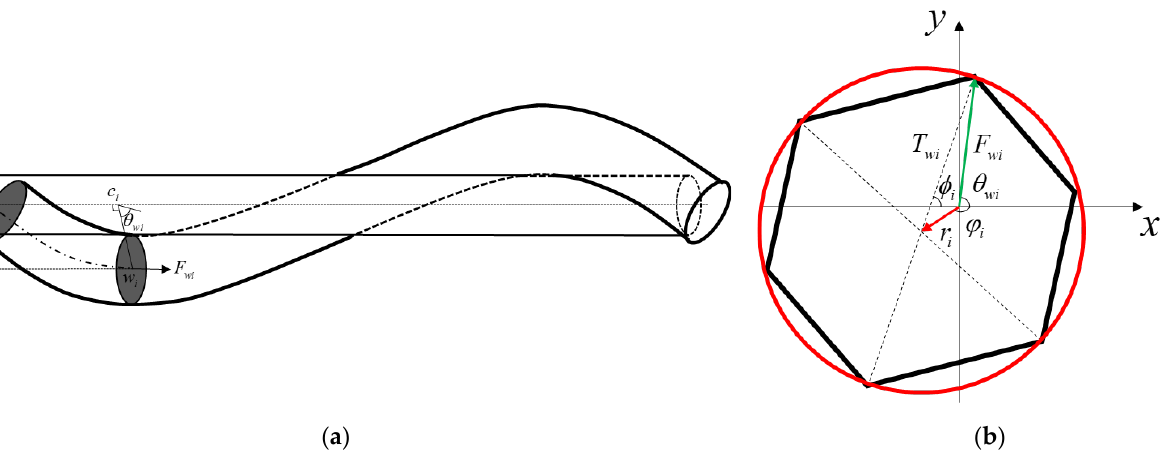
and its corresponding angular position 𝐹𝐹 𝑤𝑤𝑖𝑖